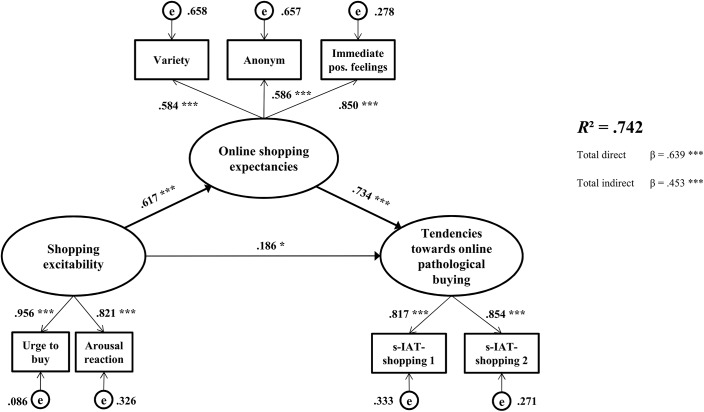
Results for the structural equation model.The factor loadings of the latent dimensions and the β-weights with the significance, as well as the total direct and total indirect effects, are depicted. e = error *** p < .001, ** p < .01, * p < .05